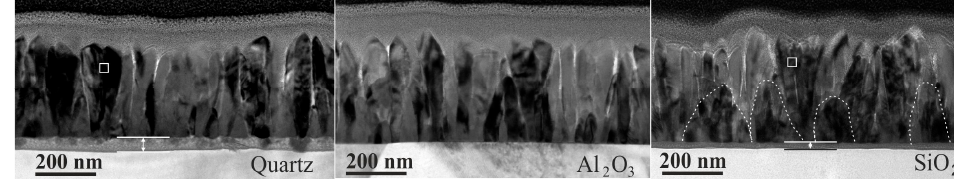
Figure 2. TEM image of the film grown on quartz, Al 2 O 3 and amorphous Si/SiO 2 substrates.